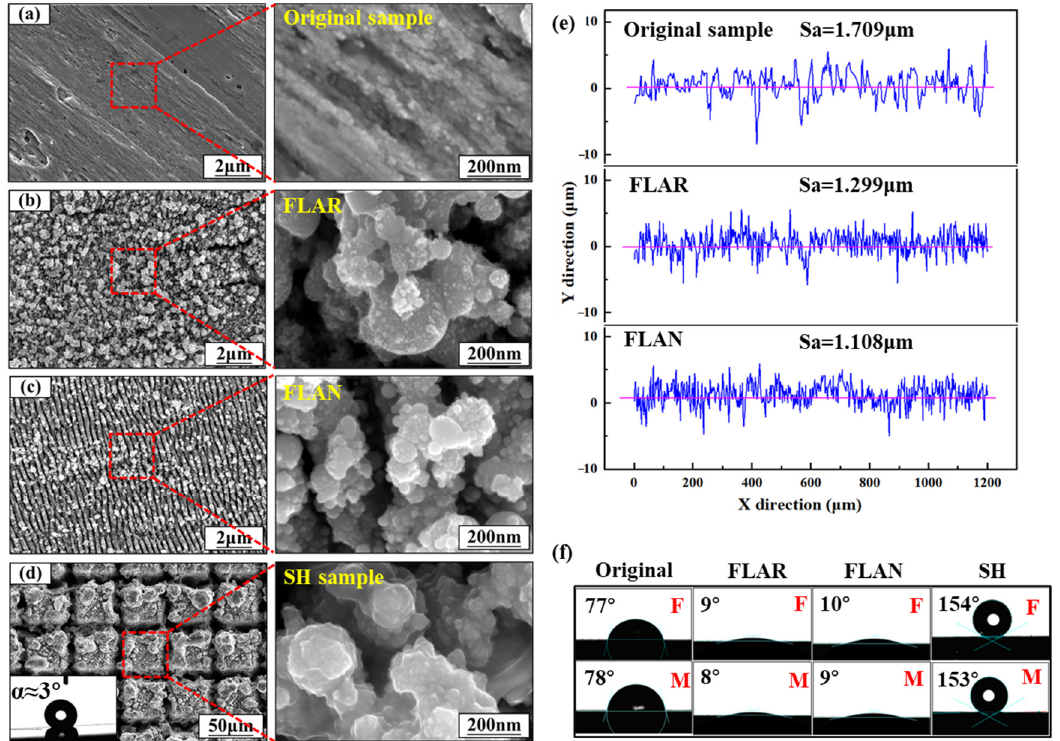
Figure 3. Surface structures of ( a ) original, ( b ) FLAR, ( c ) FLAN, and ( d ) SH samples. ( e ) Cross-section dimensions of original, FLAR, and FLAN samples. ( f ) Wetting behaviors of original, FLAR, FLAN, and SH samples.